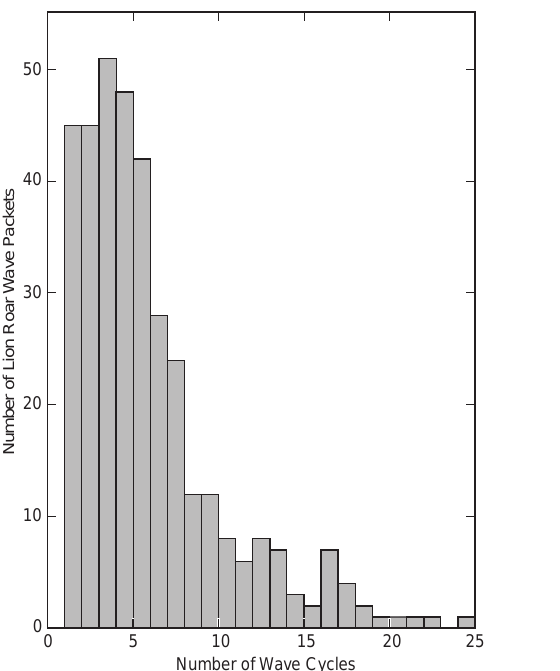
Fig. 5. Occurrence distribution of lion roar wave packet duration